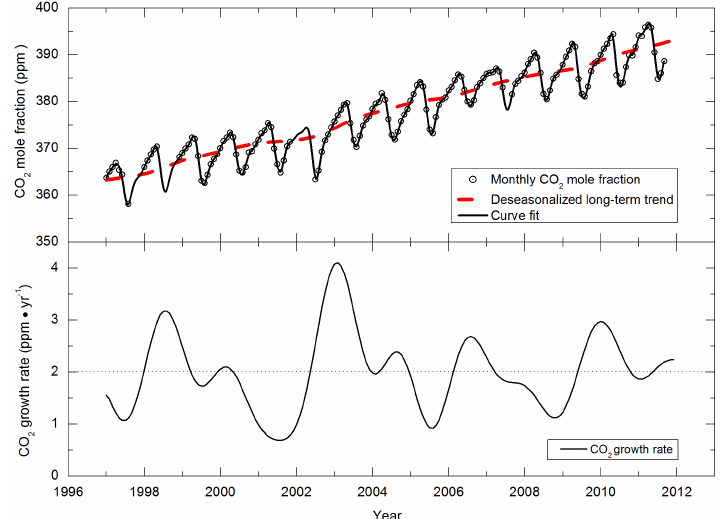
Fig. 6. Top panel: monthly CO 2 mole fractions (open circles) at WLG from 1997 to 2011, as well as the curve fit (black curve) and deseasonalized long-term trend (red dash line). Bottom panel: the annual growth rate of CO 2 . The trend, curve fit, and annual growth rate are calculated by the curve-fitting method of Thoning et al.